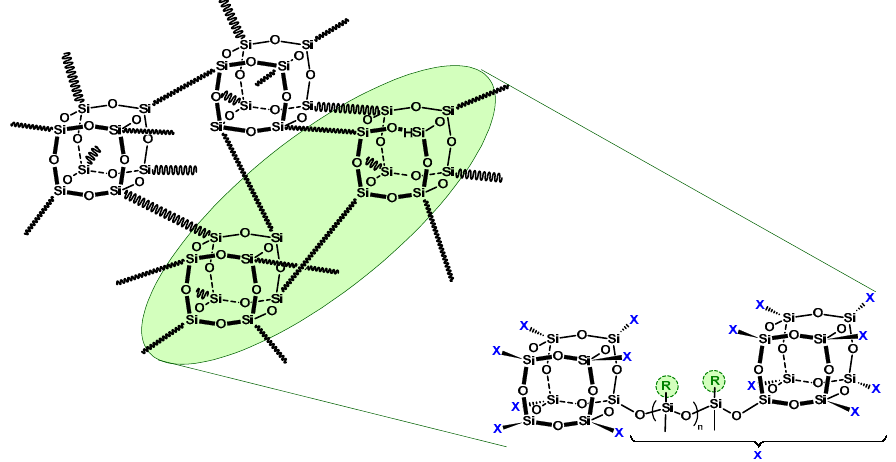
Figure 8. Structures of S4SQ-R siloxane–silsesquioxane resins.